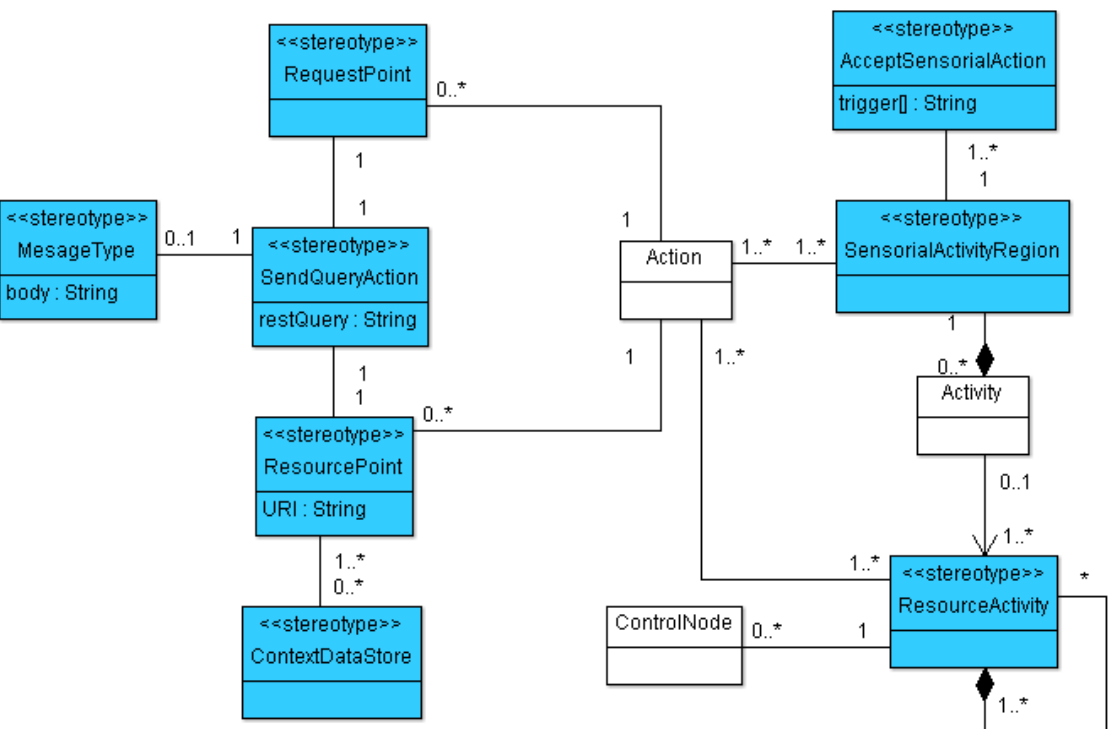
Figure 3. The ECM’s viewpoint of the SsML subset extending behavioral concepts from UML2